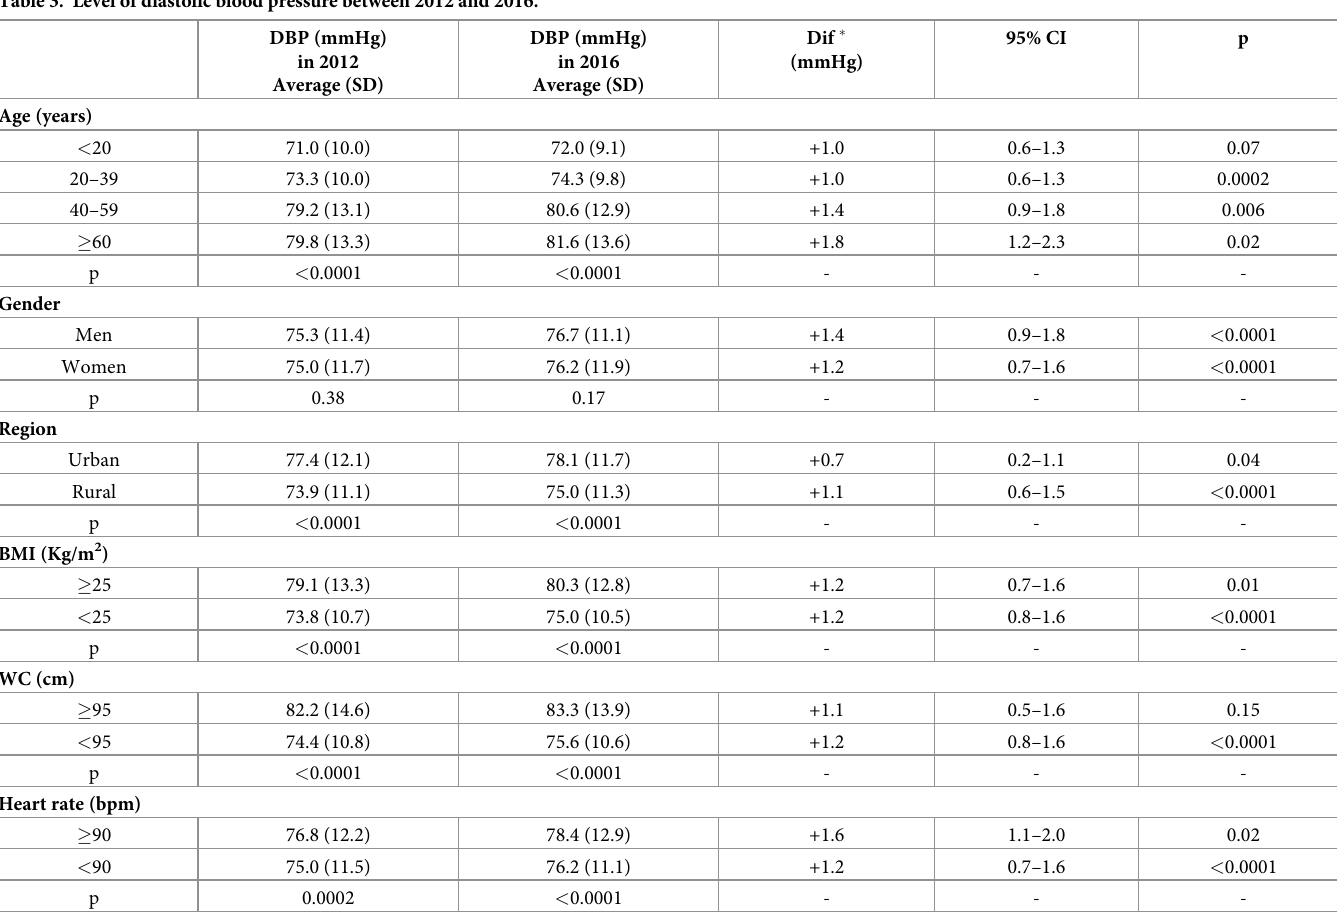
Table 3. Level of diastolic blood pressure between 2012 and 2016.